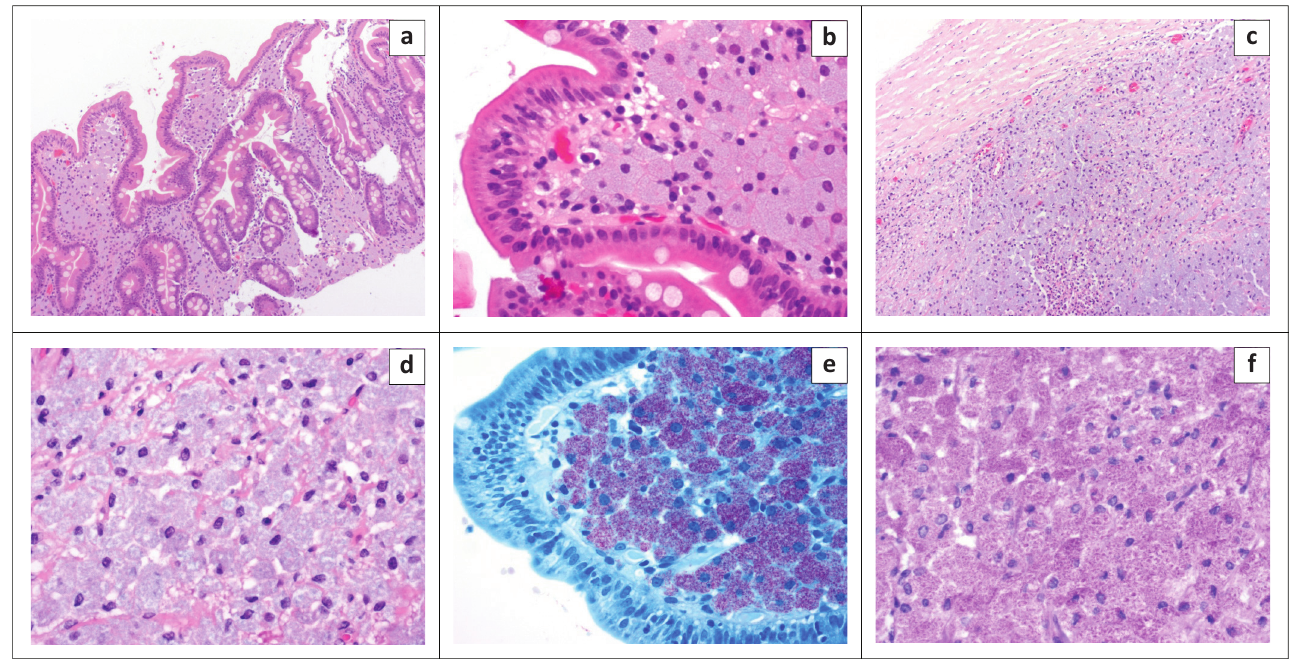
FIGURE 2: Histological images of the duodenum and lymphnode. (a) Histology of the duodenal mucosa showing lamina propria expansion by histiocyte sheets (hematoxylin and eosin, 100×). (b) Duodenal villus filled with abundant organism-containing histiocytes (hematoxylin and eosin, 400×). (c) Lymph node replaced by sheets of histiocytes with scattered intervening inflammatory cells (hematoxylin and eosin, 100×). (d) Lymph node histiocytes revealing finely granular to foamy cytoplasm, engorged with bacilli (hematoxylin and eosin, 400×). (e) Ziehl–Neelsen stain demonstrating large numbers of acid-fast bacilli in duodenal histiocytes (400×). (f) Periodic acid-Schiff stain showing granular positivity in the histiocyte intracytoplasmic organisms